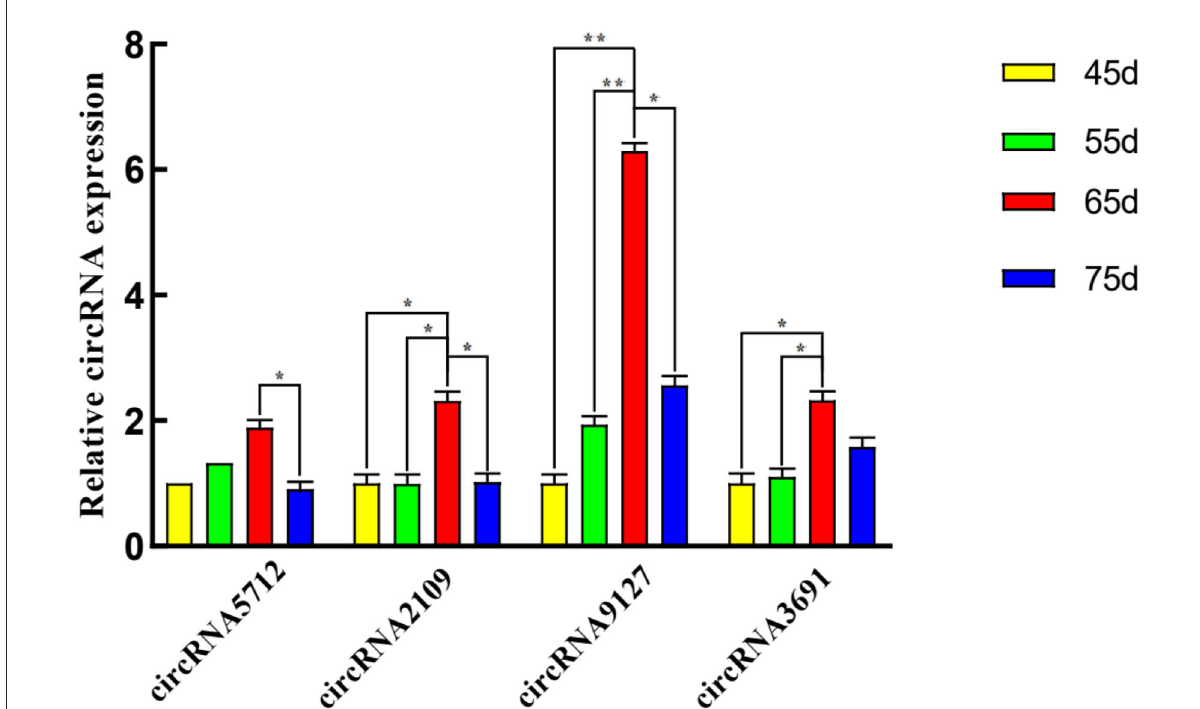
FIGURE7 qRT-PCR was used to detect the expression of circRNAs in the skin of cashmere goats at different stages. The * symbol indicates the value of P < 0.05 with significant difference. The ** represents P < 0.01 with extremely significant difference.